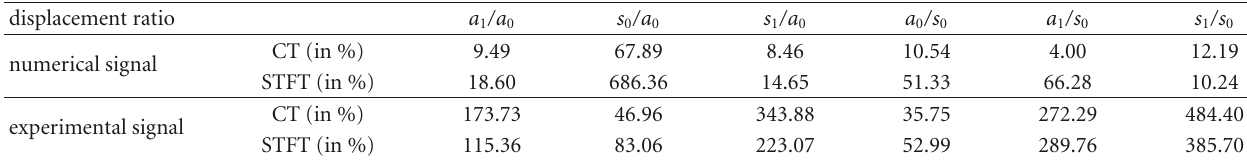
Table 1: Average deviation from theoretical mode displacement ratio in %.